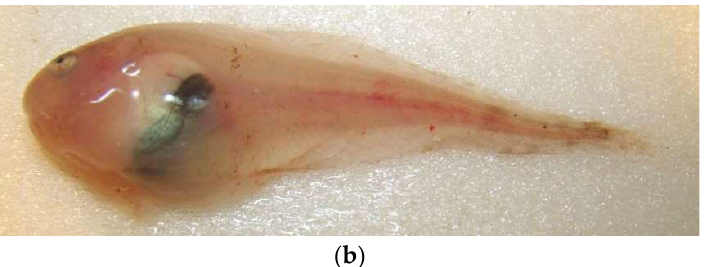
Figure 7. Arctic species of Careproctus : ( a ) Careproctus uter (sg. Careproctus ), Holotype; ( b ) C. mica (sg. Careproctula ), Holotype, TL 78 mm. Table 5. Basic characteristics of Careproctus from the Arctic and North